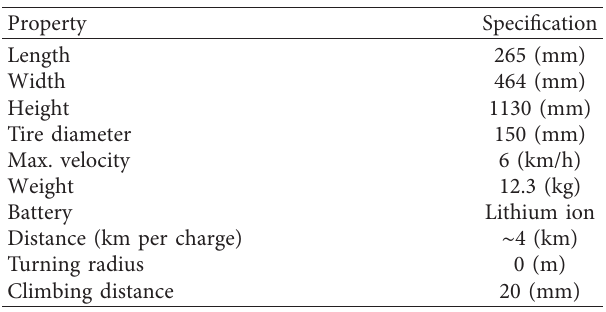
Figure 1: Winglet equipped with mobile sensors. The image shows the X , Y , and Z and roll, pitch, and yaw coordinate systems. Table 1: Winglet